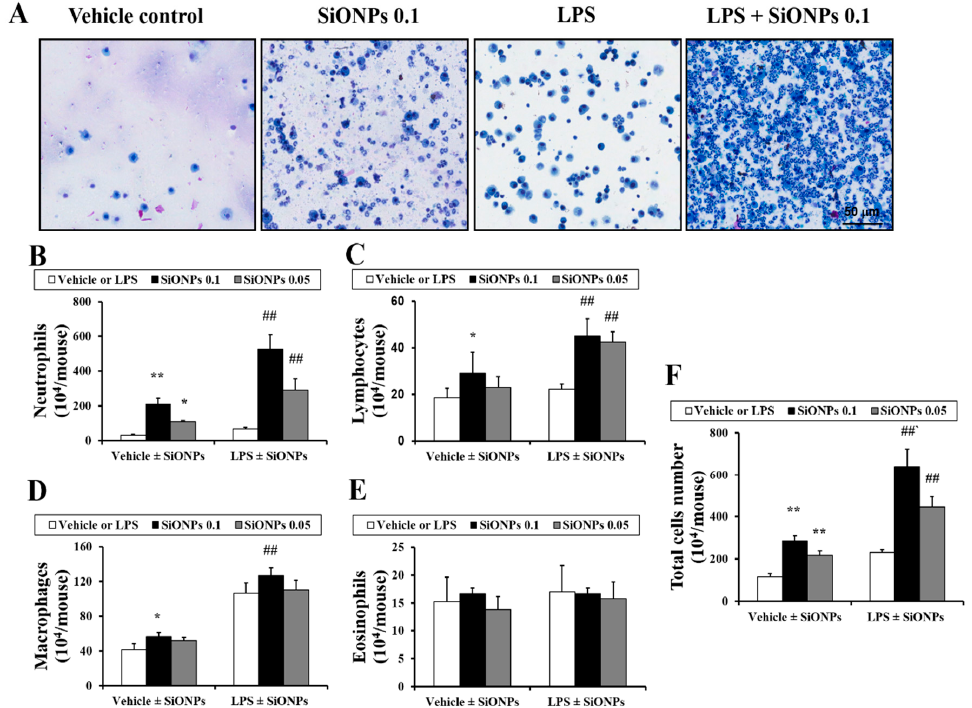
Figure 2. Effects of SiONPs exposure on inflammatory cell counts in BALF. ( A ) Representative images of inflammatory cells of each group. ( B ) Neutrophils in BALF of each group. ( C ) Lymphocytes in BALF of each group. ( D ) Macrophages in BALF of each group. ( E ) Eosinophils in BALF of each group. ( F ) Total cells in BALF of each group. Data represent the means ± SD ( n = 5 per group). * p < 0.05 and ** p < 0.01 vs. vehicle control. ## p < 0.01 vs. LPS.